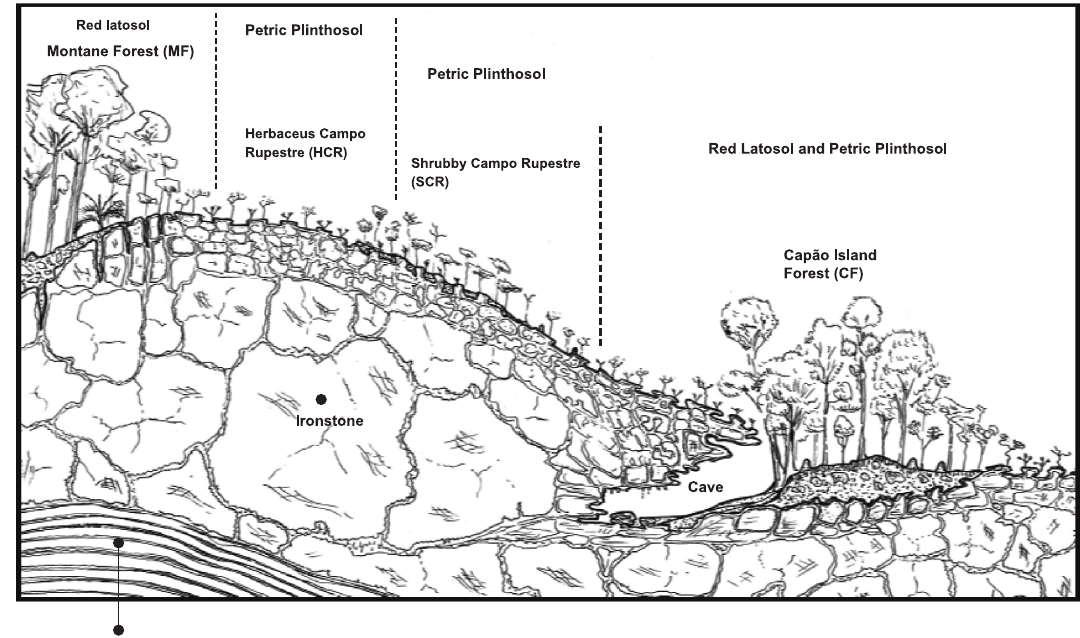
Figure 2. Profile diagram of vegetation and soils for the four different community types at National Forest Carajás, state of Pará, Brazil: herbaceous campo rupestre (HCR), shrubby campo rupestre (SCR), capão forest (CF), and montane forest